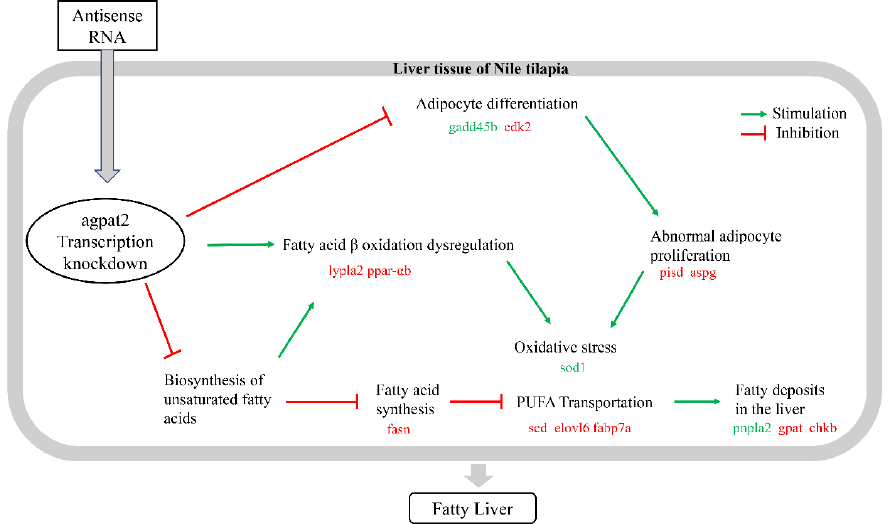
Figure 7. Schematic diagram showing the effects of AGPAT2 knock-down on the regulation of lipid metabolism and oxidative stress in the liver of Nile tilapia.